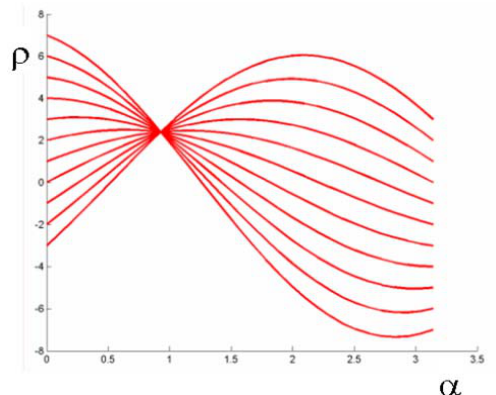
Figure 4. Image points mapped into the parameter